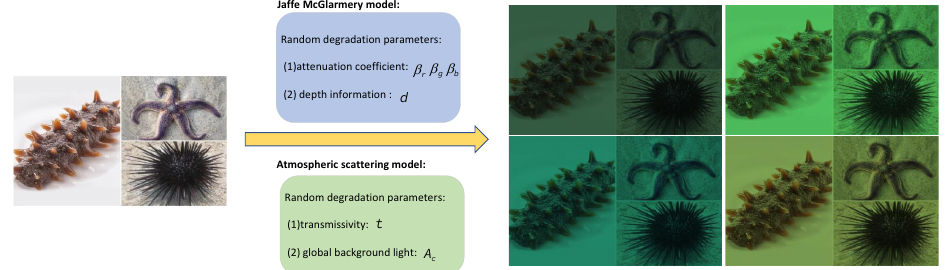
Figure 6. The general view of the proposed underwater degradation